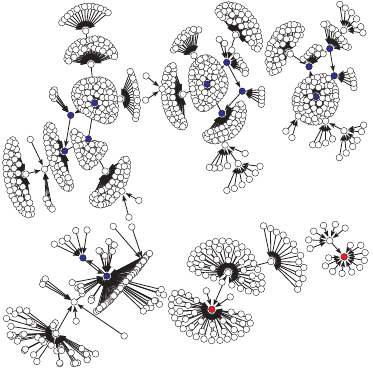
Figure 8. State transition graph of the original model under the parameters of case 4 and considering that the first nodes M , P , B , C , R , A , L , L m are updated (in parallel) and then the nodes R m , A m (also in parallel). The size of the attraction basins are 18 and 98 for the steady states ON and OFF, respectively (both in red), and 908 considering the four limit cycles (in